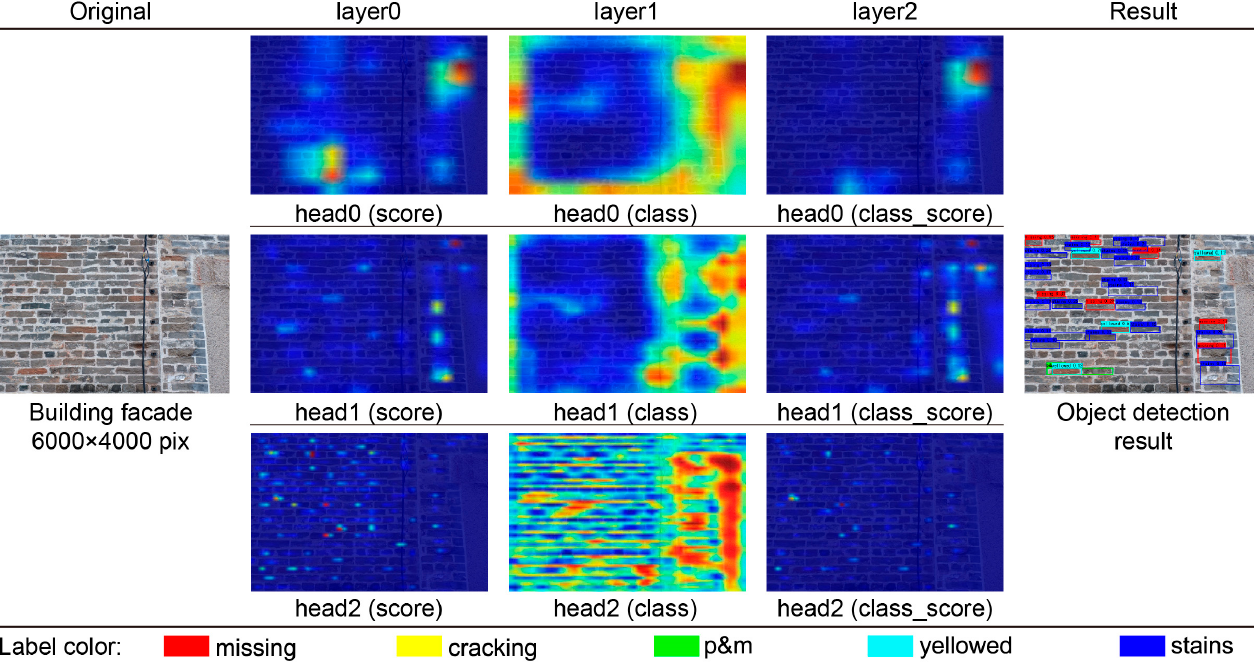
Figure 11. The feature extraction effect of the layer in the scene photo detection. (Image Source: drawn by the author). drawn by the